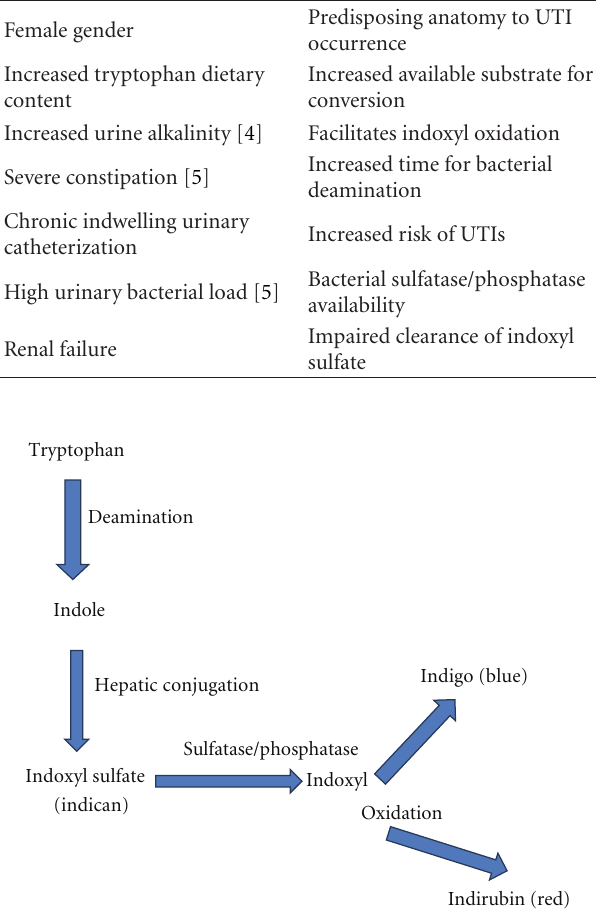
Figure 1: Biochemical pathway of conversion of tryptophan to indigo and indirubin.